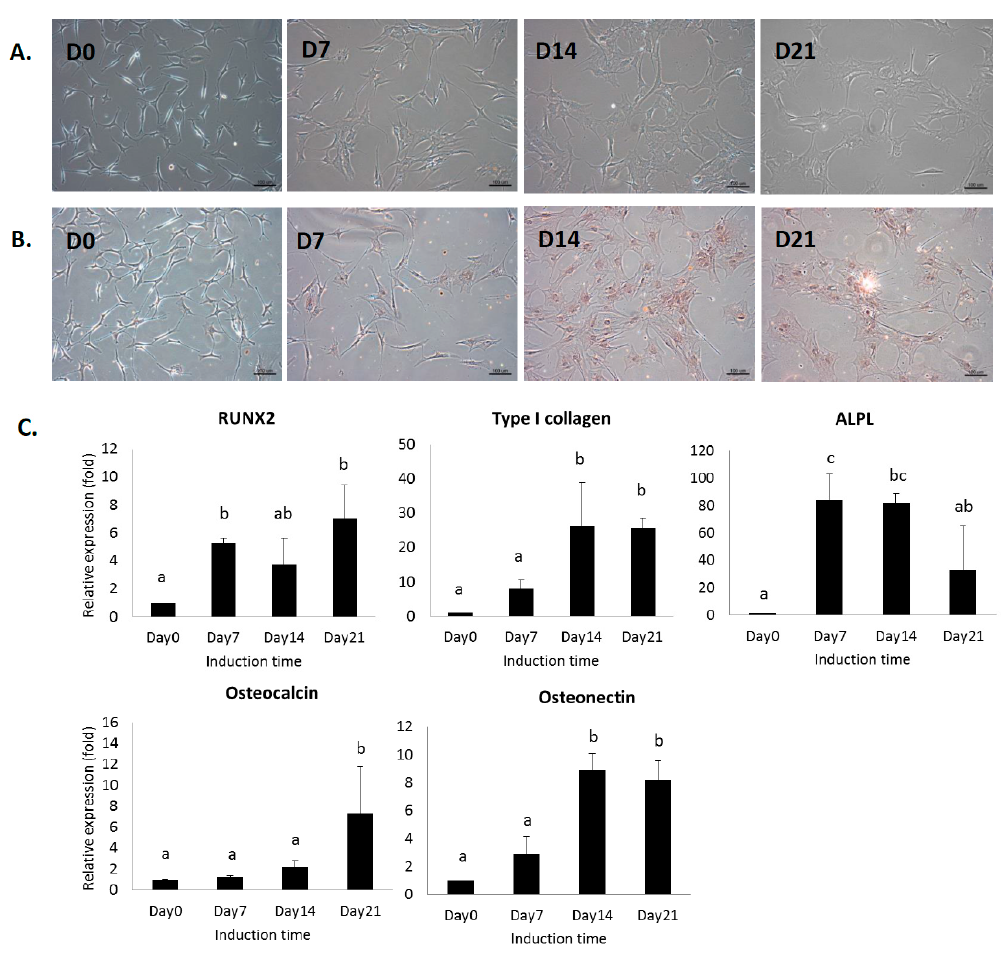
Figure 1. ( A ) Photomicrograph of mesenchymal stromal cells (MSCs) cultured on quartz coverslips in osteogenic induction medium at day 0, 7, 14, and 21. The halo regions surrounding cell edges of MSCs are the artifacts due to phase contrast microscope; ( B ) alizarin red S staining of MSCs during osteogenic differentiation. Scale bar: 100 µ m; ( C ) gene expression of osteoblast-related markers on quartz coverslips. Data are shown as mean ± SD ( n = 3). One-way analysis of variance (ANOVA) followed by Tukey’s post-hoc tests was performed for multiple comparisons. Different letters represent significant differences between groups ( p < 0.05). For example, a and b represent significant difference, a and bc represent significant difference, whereas a and ab do not.